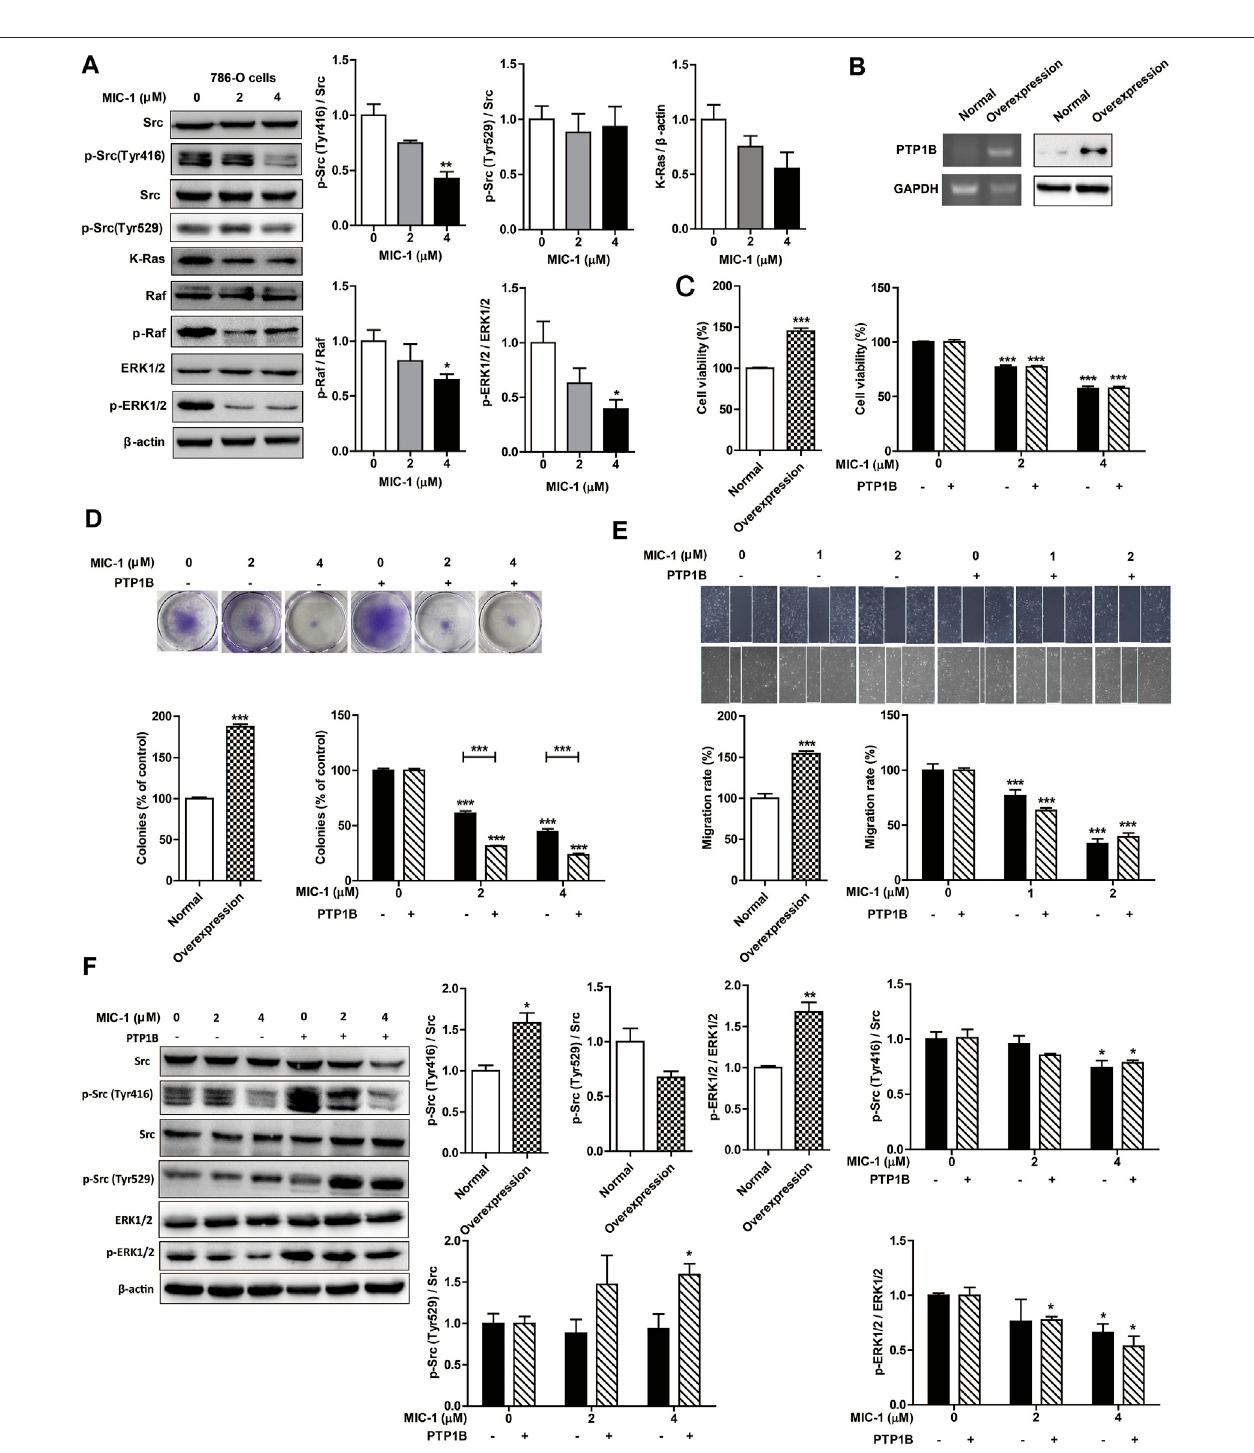
FIGURE 5 | MIC-1 inhibits the growth and migration of 786-O cells by inhibiting the PTP1B-mediated activation of the Src/Ras/Raf/ERK signaling pathway. (A) 786-O cells were treated with MIC-1 (0, 2, or 4 μ M) for 48 h, and the expression of Src, p-Src (Tyr416), p-Src (Tyr529), K-Ras, Raf, p-Raf, ERK1/2, and p-ERK1/2 was detected by western blotting. β -actin served as a loading control. (B) Detection of PTP1B mRNA and protein expression in 786-O cells transfected with a PTP1B cDNA expression vector by RT-PCR and western blotting, respectively. (C) Untransfected and PTP1B-overexpressing 786-O cells were treated with different concentrationsofMIC-1(0,2,or4 μ M)for48 hafterwhichcellviabilitywasanalyzedbytheMTTassay. (D) Clonogenicabilitywasanalyzedbyacolonyformationassay. (E) Untransfected and PTP1B-overexpressing 786-O cells were treated with different concentrations of MIC-1 (0, 1, or 2 μ M) for 24 h after which migratory ability was